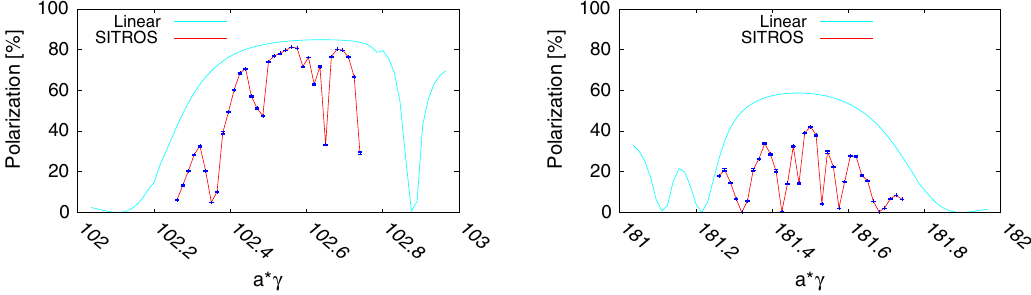
¼ 200 μ m and 10% y